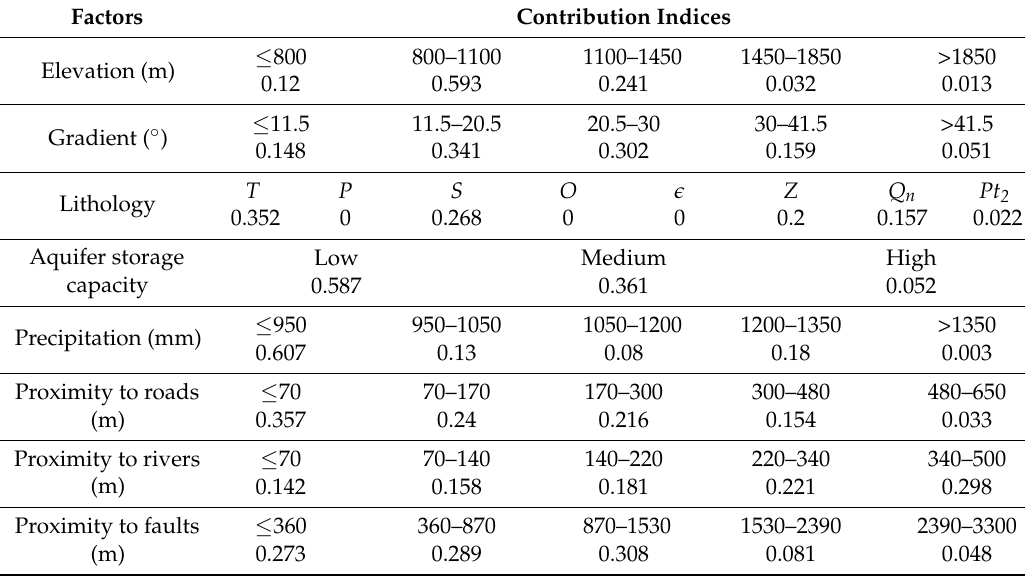
Table 5. Contribution indices of influence factors.